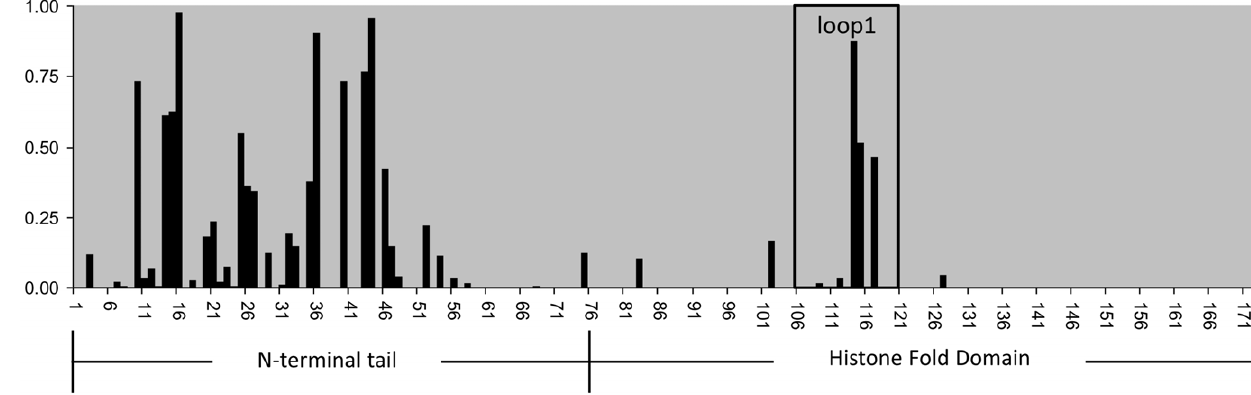
Figure 1. Posterior probabilities that each residue of the CENH3 HCP-3 is positively selected under M8 model.